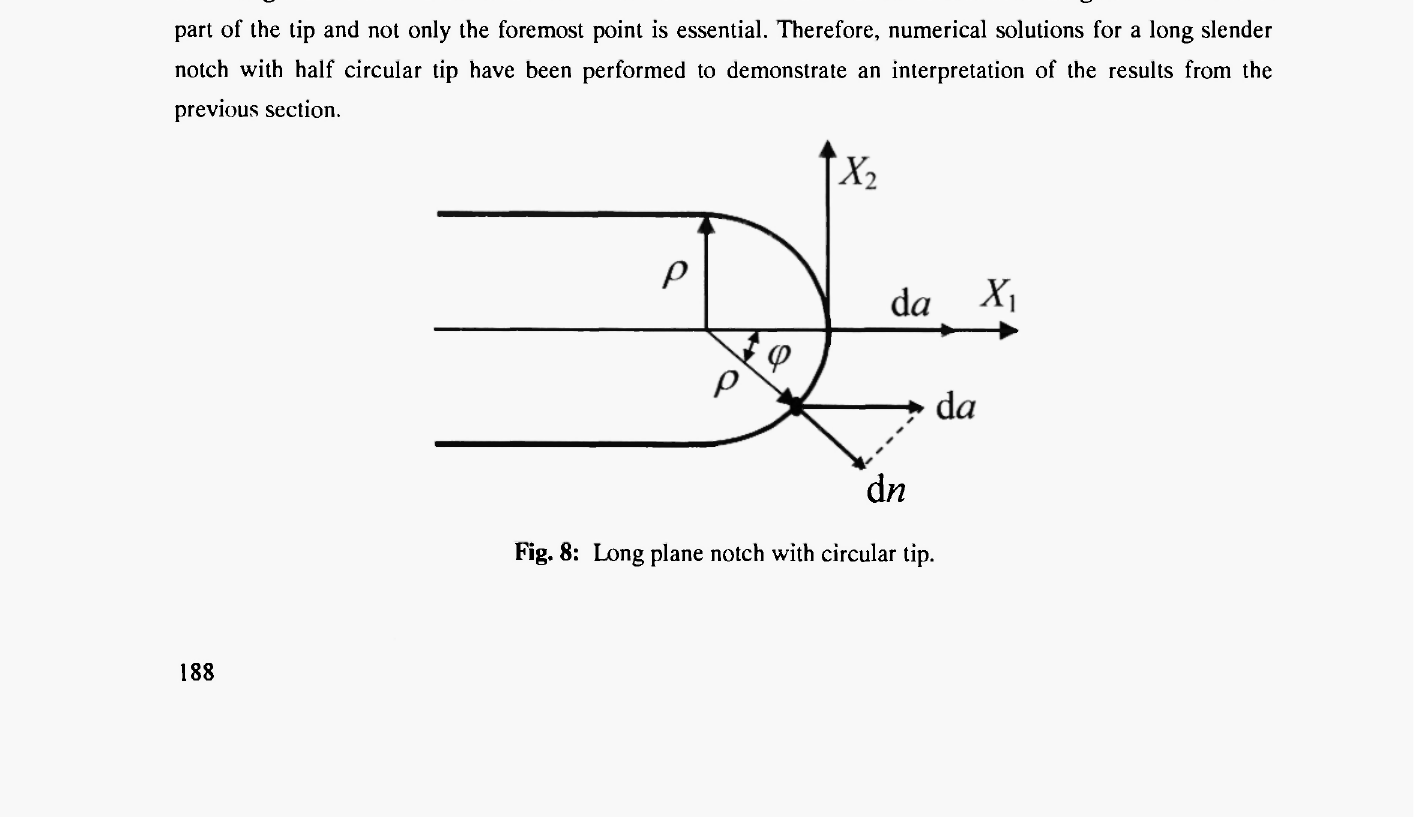
Fig. 8: Long plane notch with circular